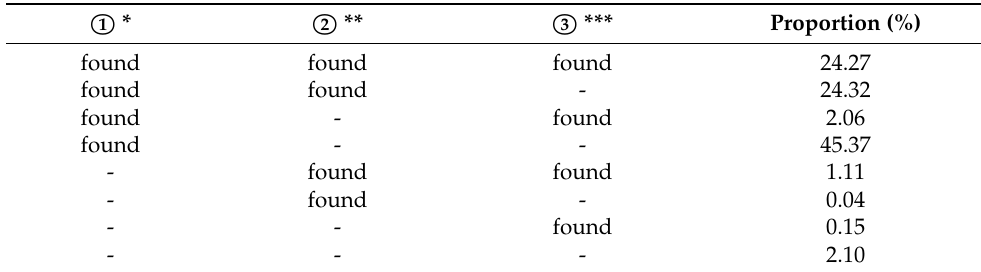
Table 4. Cases of evaluated results by proposed method.